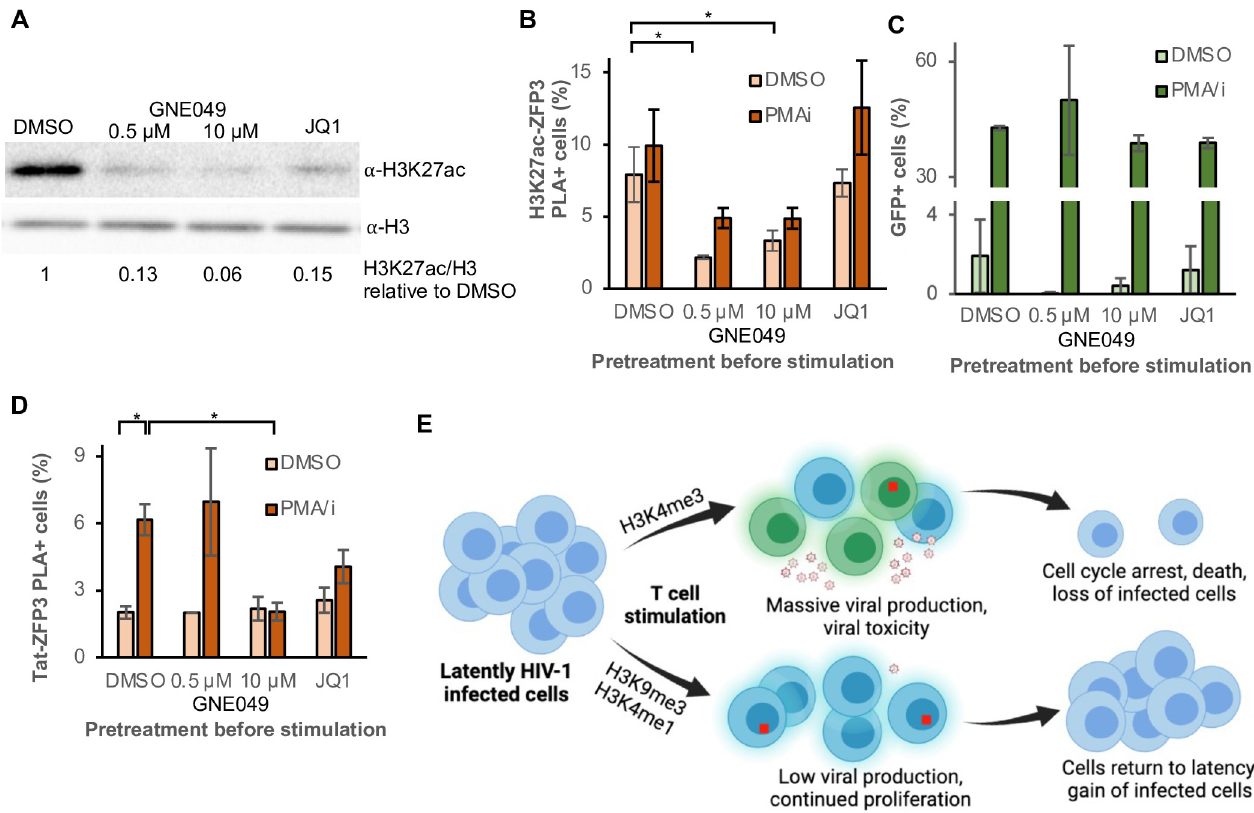
Fig 6. GNE049 reduces H3K27ac and prevents Tat at the promoter without affecting HIV-1 activation. (A) H3K27ac-ZFP3 PLA in cells pretreated with GNE049 (a CBP/P300 inhibitor of enhancer H3K27ac) or DMSO for 3 h followed by 16 h with DMSO or PMA/i. (B) Tat-ZFP3 PLA in the same cells as in (A). (C) Percentage of total GFP + cells treated as in (A). (D) Model of different reservoir compartments after T cell stimulation: upper) high viral production, both dependent and independent of Tat, toxicity leads to cell cycle arrest and cell death; lower) low Tat-mediated viral production in cells with proviral H3K9me3 or H3K4me1, where cells proliferate and return to